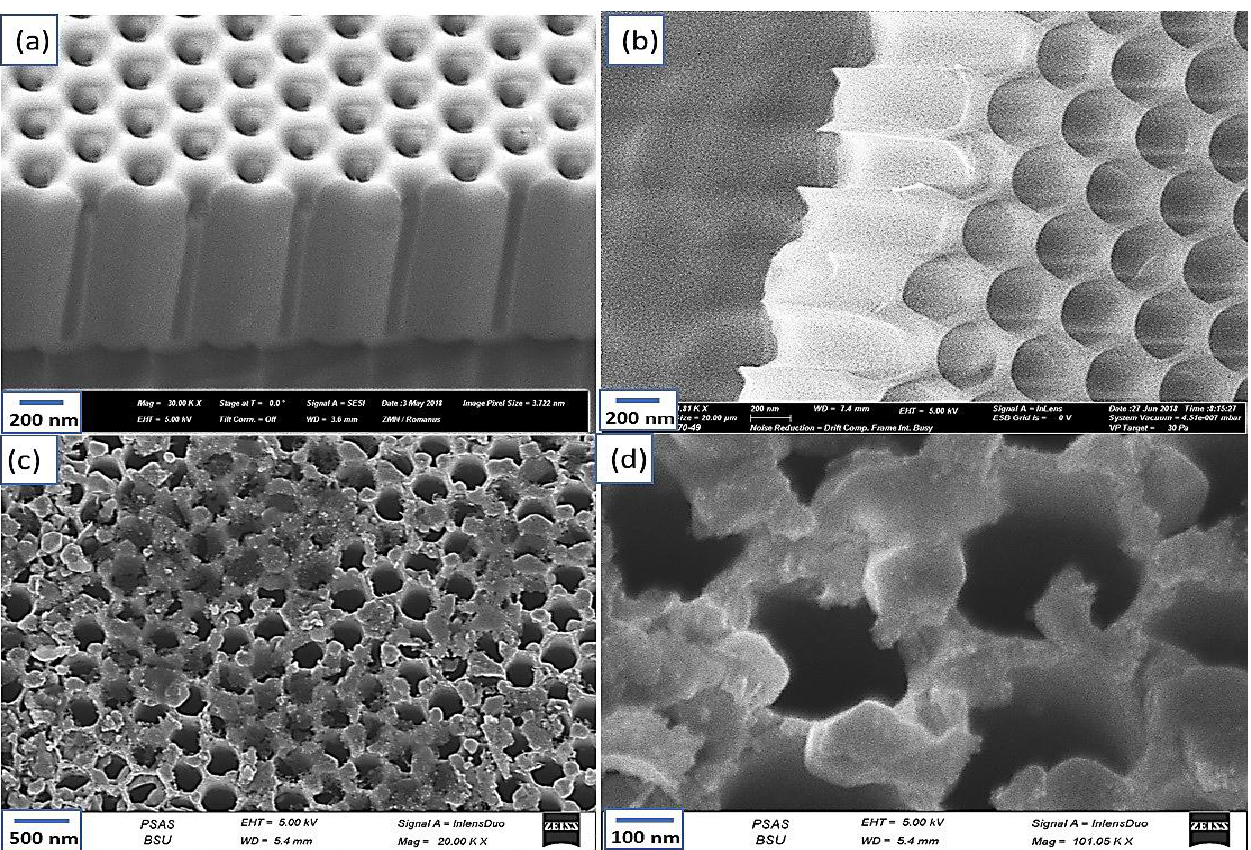
Figure 4. SEM of Al 2 O 3 template ( a ) before and ( b ) after pore widening. SEM of ( c , d ) Ag 2 O-Ag/Au on the Al 2 O 3 template under different magnifications.